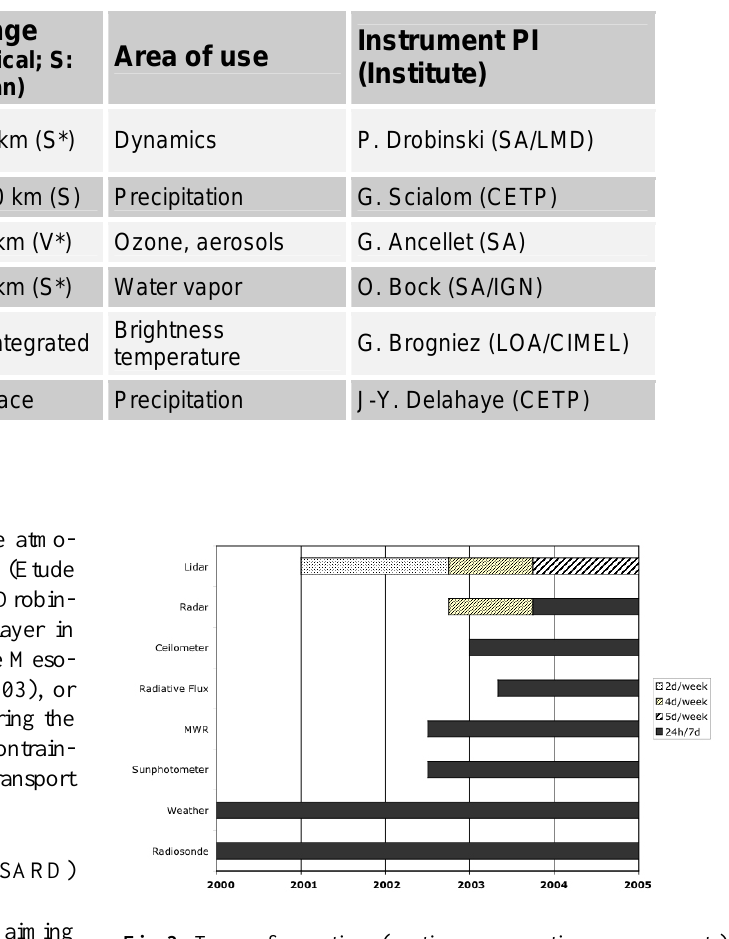
Fig. 3. Types of operations (continuous or routine measurements) for each instrument listed in Table